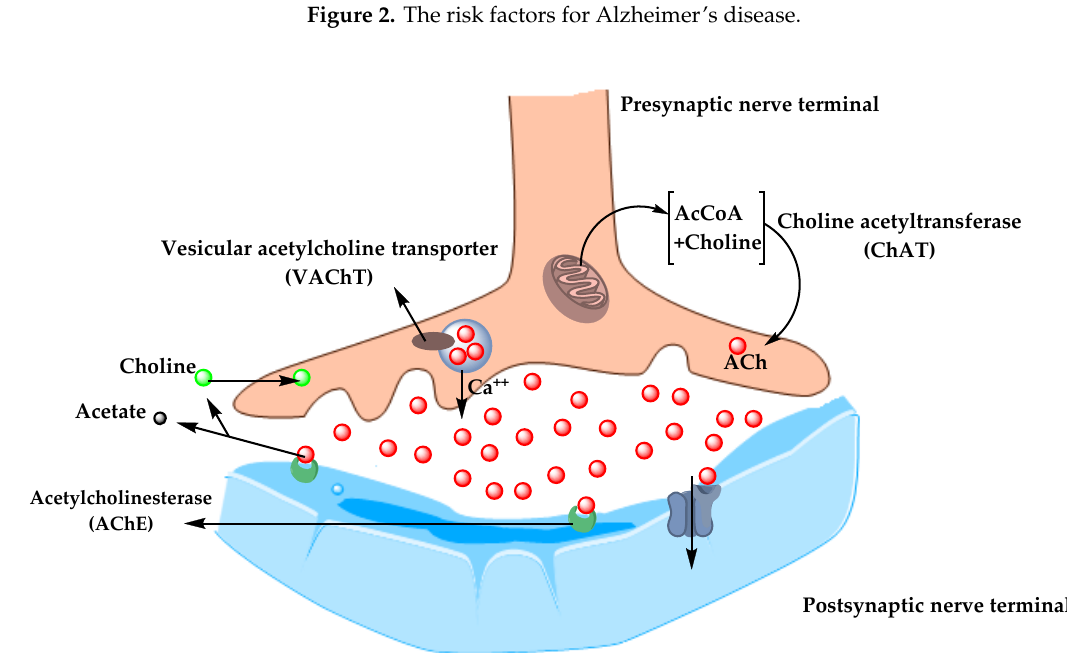
Figure 3. The pathway for the synthesis and transportation of acetylcholine between presynaptic and postsynaptic nerve